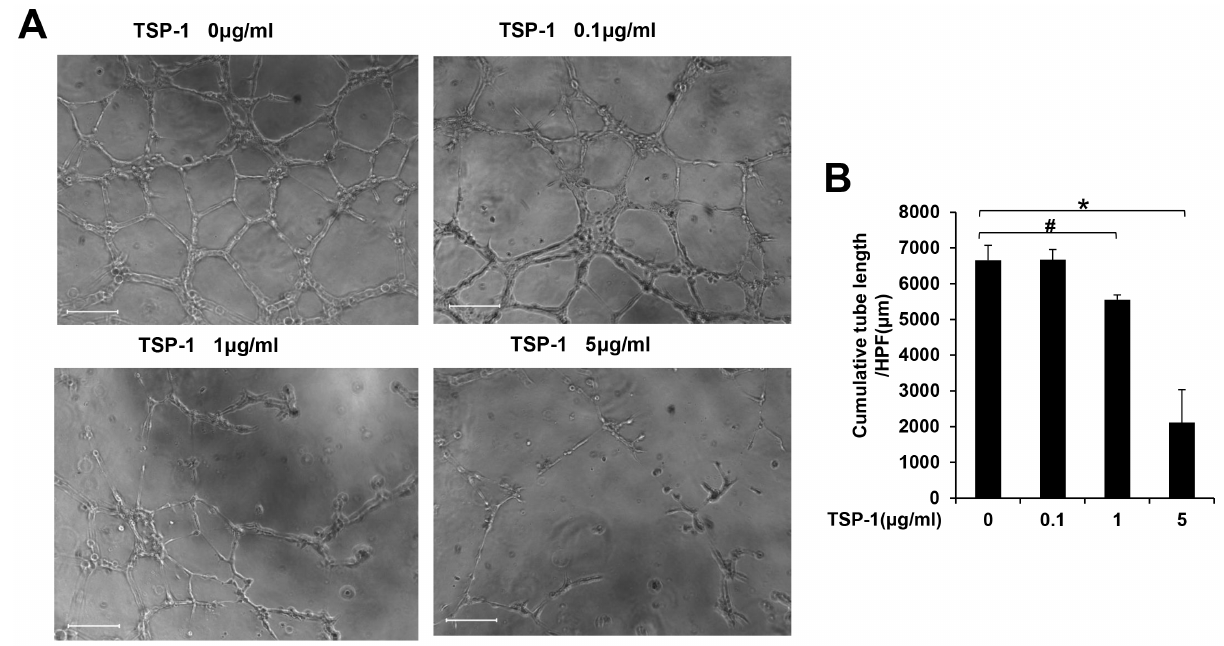
Figure 3. TSP-1 inhibited late EPCs tubule formation on Matrigel. (A) Late EPCs were plated on Matrigel with TSP-1 at different concentrations for 8 hrs (Scale bar=200 m m, 100 6 magnification). (B) Quantification of total tube length per high power field (HPF, 100 6 magnification) was presented as mean 6 S.D. of three independent experiments ( # p , 0.05 versus no TSP-1 intervention, *p , 0.01 versus no TSP-1 intervention).